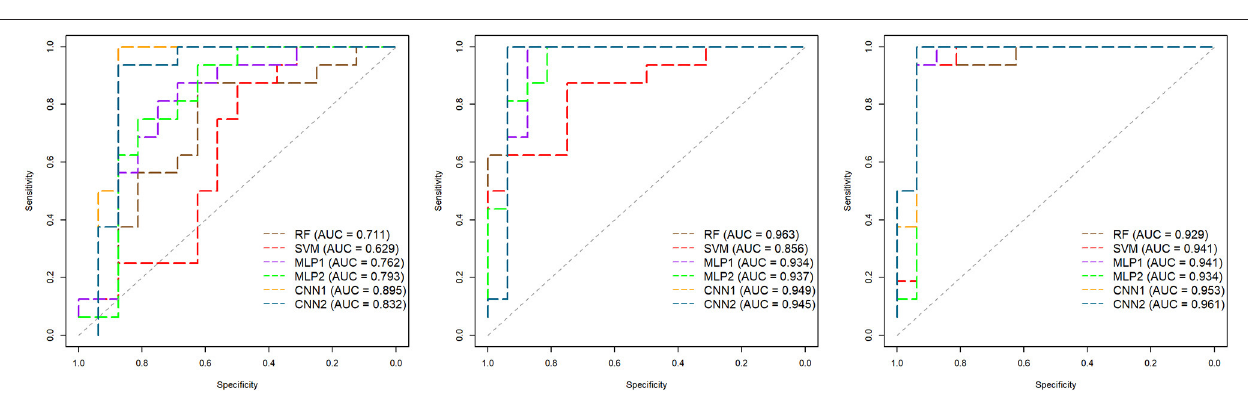
FIGURE 11 | Receiver operating characteristic (ROC) curves and respective area under the ROC curves (AUC) for the classification of Brazilian horses gait types (MB or MP) obtained in an independent dataset ( N 32) according to the algorithm (RF, Random Forest; SVM, Support Vector Machine; MLP, Multilayer Perceptron Neural = Networks; CNN, Convolutional Neural Networks) and the audio-feature dataset ( Left —Mel-frequency Cepstral Coefficients, Middle —Onset Strength, and Right —Tempogram). The diagonal dashed line represents a random guess. MLP1, MLP2, CNN1, and CNN2 refer to the different neural network architectures used for each audio-feature dataset (as fully presented in Supplementary Table 1